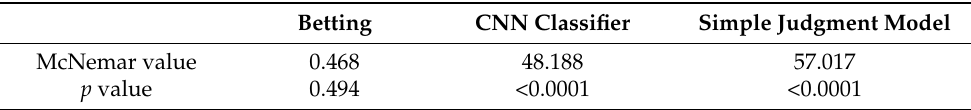
Table 3. McNemar test results for the pairwise comparison of the predictive outcome with the logistic